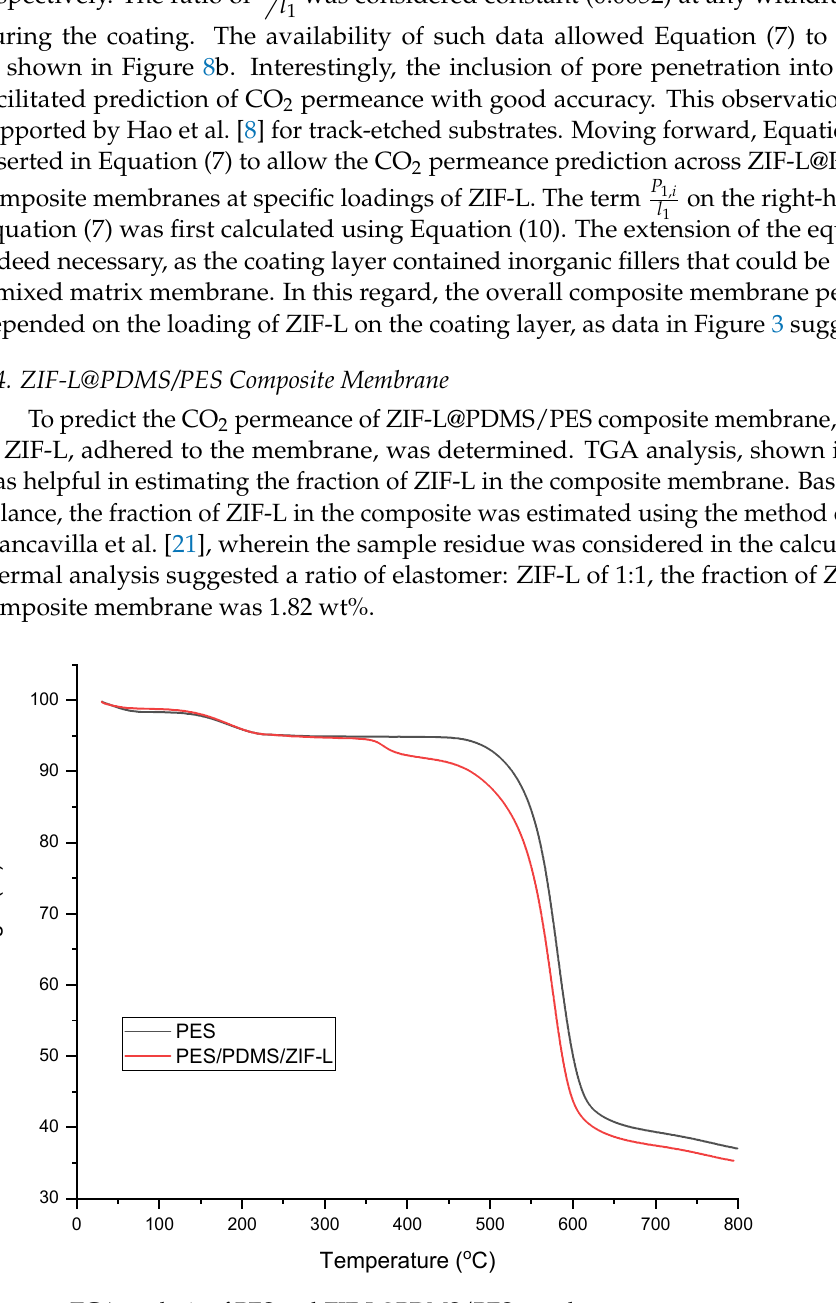
Table 2. Predicted and experimental data of CO 2 permeance in ZIF-L@PDMS/PES composite membrane. Selectivity Permeance (GPU)